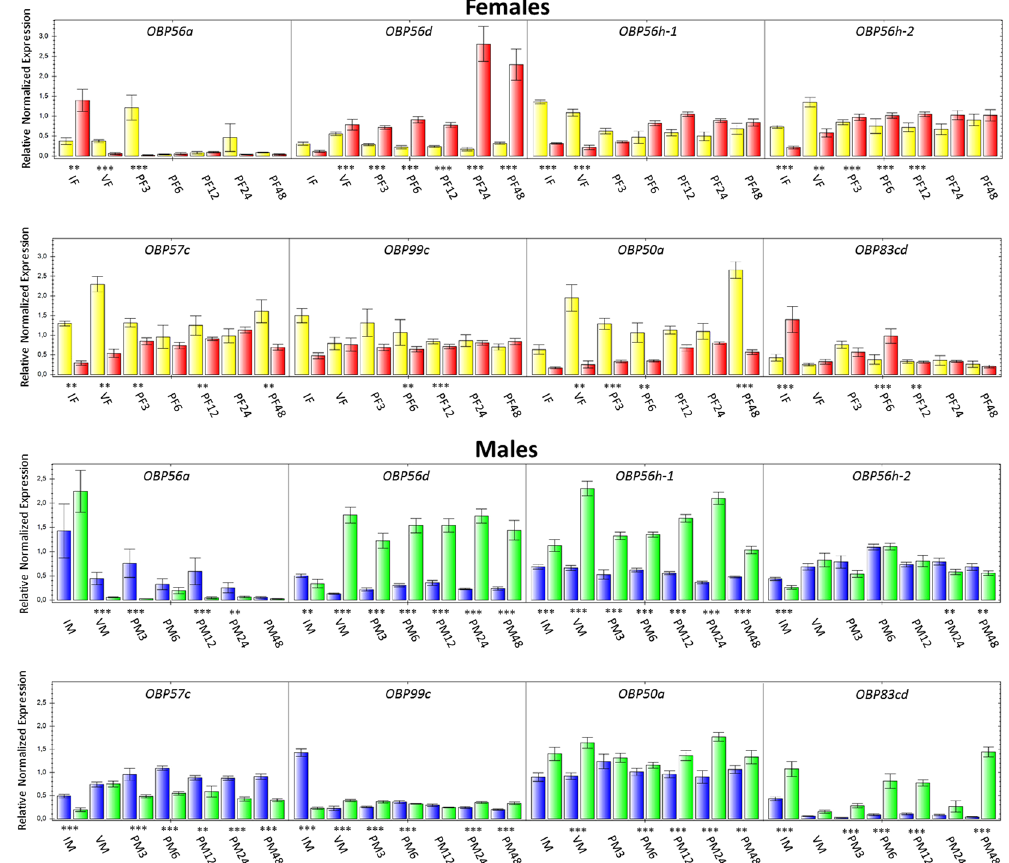
Figure 4. Comparative gene expression of OBP genes between A . fraterculus and A . obliqua . Yellow and blue bars represent A . fraterculus reproductive stages in females and males, respectively. Red and green bars represent A . obliqua reproductive stages in females and males, respectively. IF = immature female; VF = virgin female; PF3 = 3 h post-mating female; PF6 = 6 h post-mating female; PF12 = 12 h post-mating female; PF24 = 24 h post-mating female; PF48 = 48 h post-mating female. IM = immature male; VM = virgin male; PM3 = 3 h post- mating male; PM6 = 6 h post-mating male; PM12 = 12 h post-mating male; PM24 = 24 h post-mating male; PM48 = 48 h post-mating male. Unpaired t-test: ** p-value < 0.01; *** p-value <